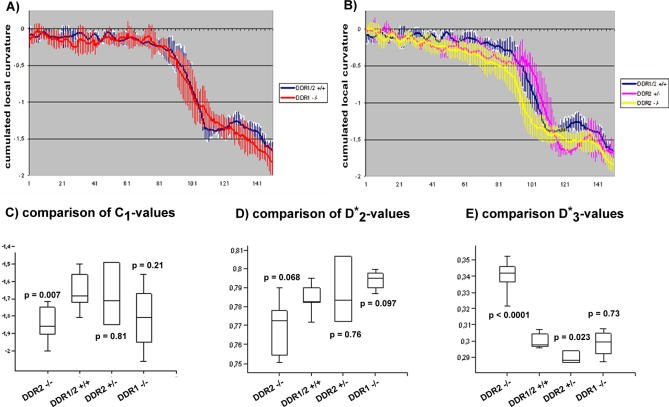
Statistical Evaluation of Various Metrical Skull Features(A, B) Progression of the cumulative local contour curvatures C
1 follows the contour positions of knockout mice and their controls. Shown are the mean values and the local standard deviations for each mice strain.(C–E) Box plots for C
1, D
*
2, and D
*
3 values are shown. p-Values for the paired Student's t-test for each feature of every strain are indicated in comparison to wild-type controls. Differences with p < 0.05 were considered to be significant. Note, that parameters C
1 and D
*
3 in DDR2-deficient mice, D
*
3 in heterozygous DDR2-deficient mice, and D
*
2 in DDR1-deficient mice differ significantly in comparison to wild-type controls.